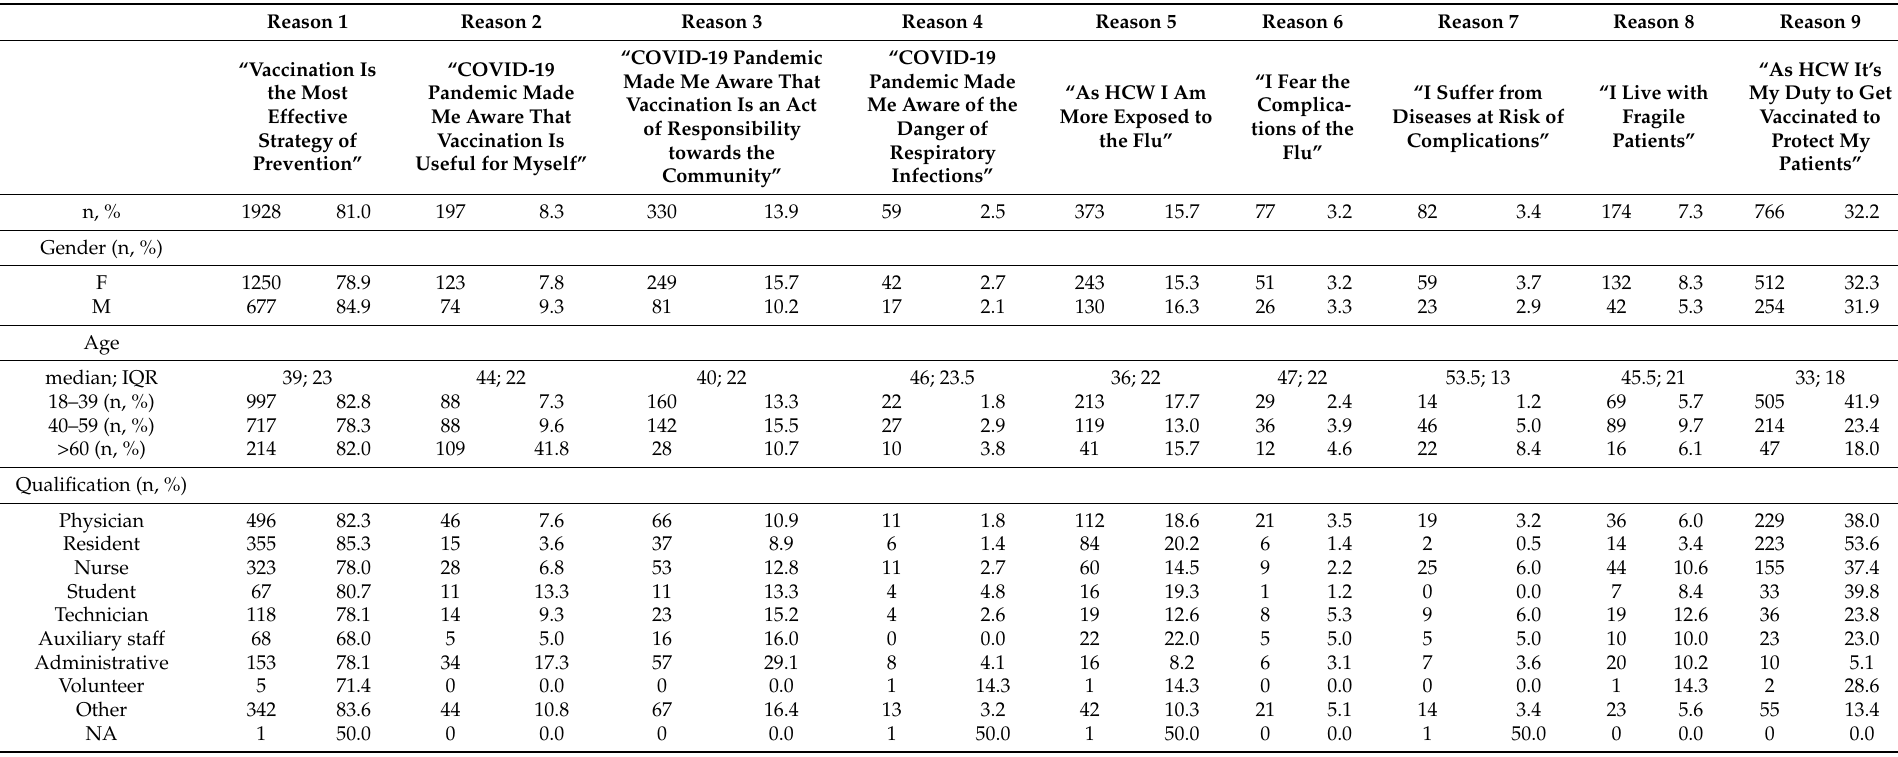
Table 2. Reasons for influenza vaccination uptake; season 2021–2022. Reasons are progressively listed as they were displayed in the questionnaire. Note that, as every HCW could express more than one reason (maximum two), cumulative sum of relative frequencies for each reason overcomes